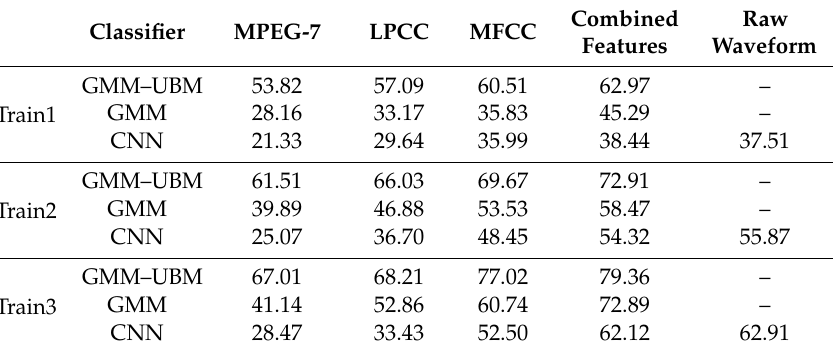
Table 4. F-macro of individual violin recognition